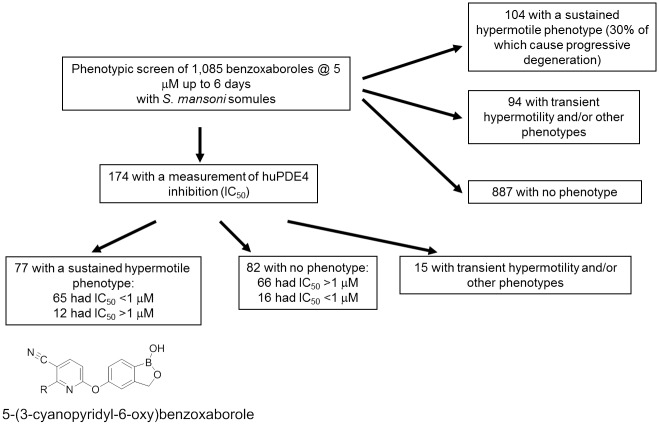
Phenotypic screening of a benzoxaborole collection with S. mansoni somules suggests a PDE4 as a molecular target of interest.The screen involving 1,085 benzoxaboroles was performed at 5 μM for 6 days with observations taken every day using a constrained nomenclature, as noted in the text. Three main phenotype response groups could be adjudicated by microscopical observation: (i) 104 compounds eliciting an early and sustained hypermotile phenotype, of which, 30% was also associated with a parasite degeneration; (ii) 94 compounds that yielded a range of phenotypic responses (e.g., rounding, darkening), including hypermotility, which were either transient (noted at 24 h only) or appeared later (on or after day 3 of the incubation), and (iii) 887 compounds that produced no phenotype. Of the 1,085 benzoxaboroles screened, 174 also had IC50 data for inhibition of huPDE4B2 that were distributed as 77, 82 and 15 compounds across the sustained hypermotile, no phenotype and transient hypermotile groups, respectively. Sixty-five of 77 compounds in the sustained hypermotile group inhibited huPDE4B2 with IC50 values of < 1 μM. In contrast, for the no phenotype group, only 16 of 82 compounds had IC50 values of < 1 μM. The association between the sustained hypermotile phenotype and sub-micromolar inhibition of huPDE4 was highly significant with a Fishers exact p-value of <0.0001. The 5-(3-cyanopyridyl-6-oxy) benzoxaborole scaffold, which is known to preferentially inhibit huPDE4 over other PDEs [73], was well represented in Group 1.